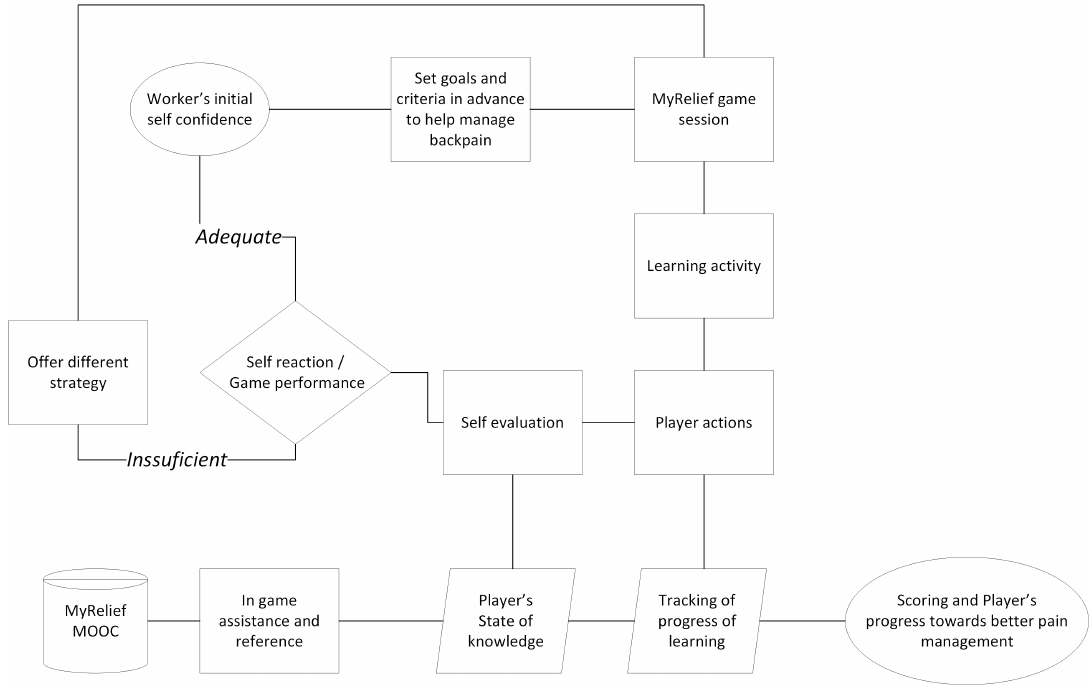
Figure 2. Knowledge transfer